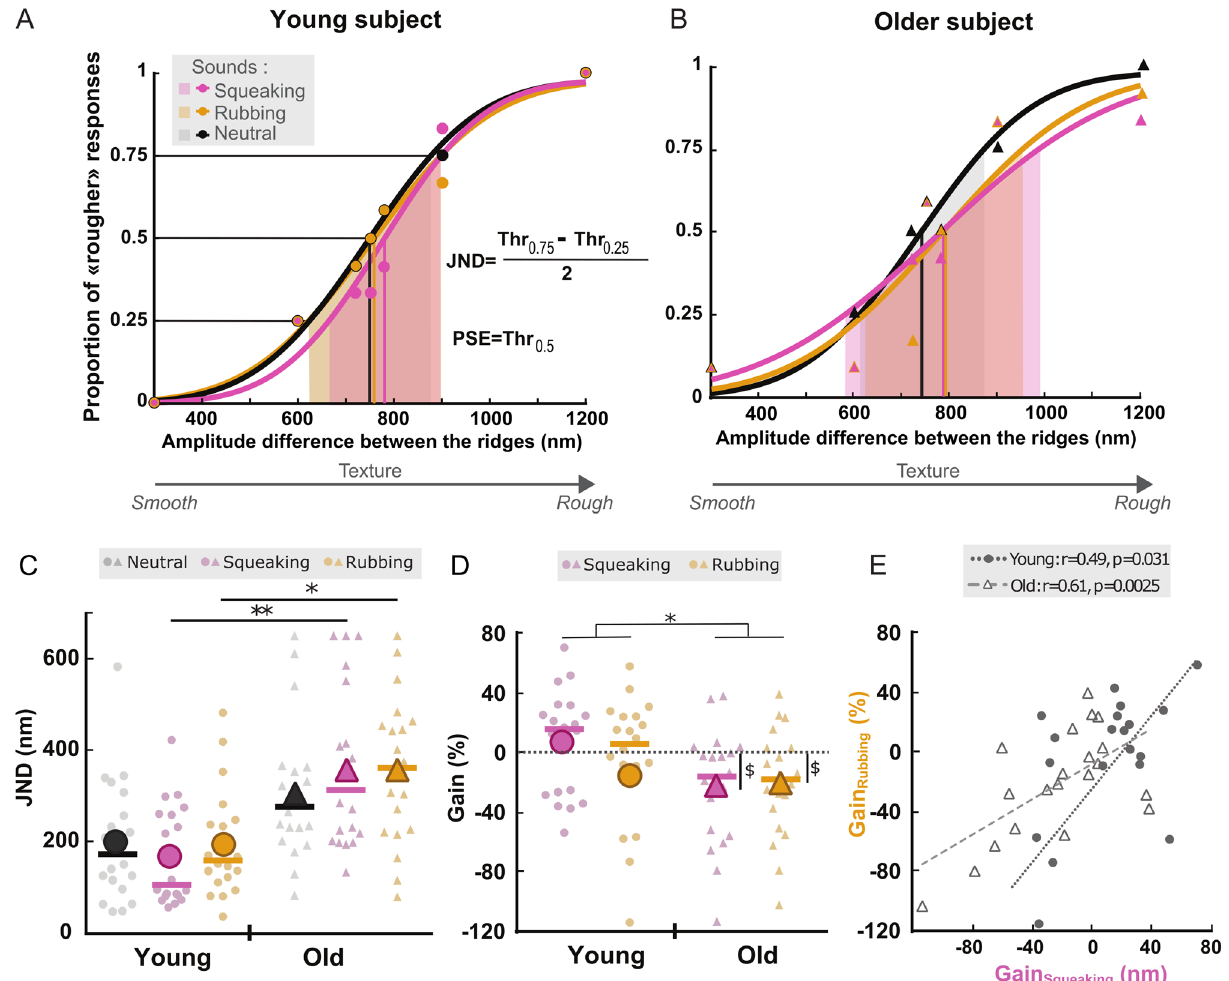
Figure 2. Typical psychophysical curves from one young ( A ) and one older participant ( B ) reflecting the percentage of texture stimuli perceived rougher than the reference texture (ΔA = 750 nm) for each sound condition: Squeaking (pink), Rubbing (yellow) and Neutral (black). Symbols are the mean values obtained for 7 textures varying in roughness. JND: just noticeable difference; PSE: point of subjective equality. ( C ) Individual and mean JND values for the younger (dots) and older participants (triangles) in each sound condition: Squeaking (pink), Rubbing (yellow) and Neutral (black). Statistics are post hoc tests after Holm correction * ( D ) Individual and mean Gain indexes (%) (Squeaking in pink and Rubbing in yellow) for the younger (dots) and older (triangles) participants. The largest symbols are the mean of the groups and the horizontal bars are the median. Statistics are the main effect of the GLM (*) and t -tests different from zero ($). ( E ) Correlations between the two Gain indexes (Squeaking and Rubbing) within each group (Young: black dot line; Old: grey dash line). * or $ p < 0.05; ** p < 0.01. Thr Threshold.